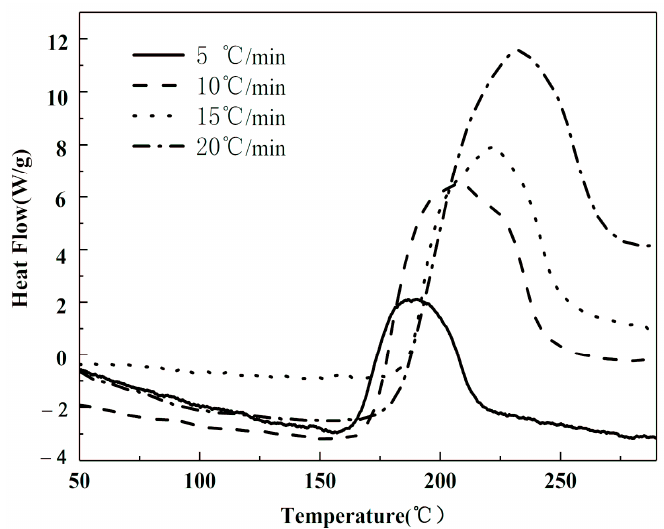
Figure 5. Non-isothermal differential scanning calorimetry (DSC) curves of the HTPB-IPDI system at different heating rates .